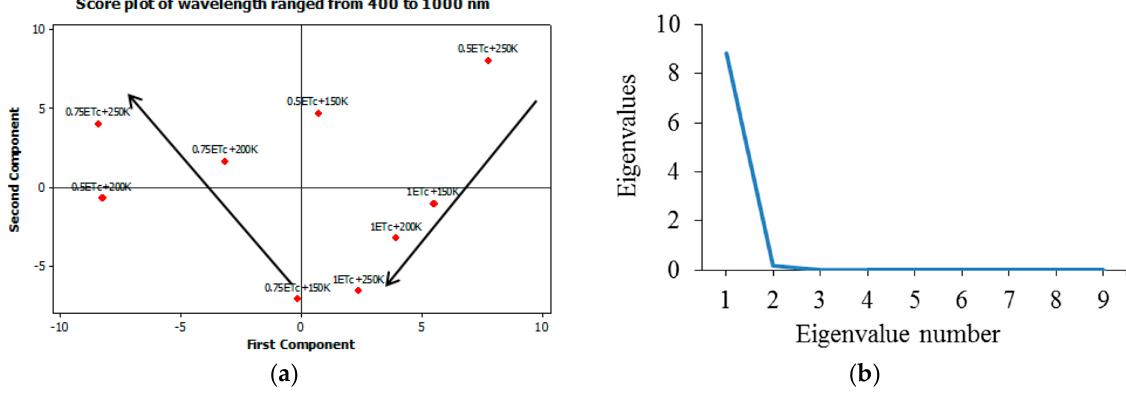
Figure 3. The score plot of ( a ) PCA and ( b ) Eigenvalue number created for the spectral measure- ments acquired from non-stressed and stressed squash plants at the flowering stage in spring season. Treatment labels; 0.50ETc + 150K (50% ETc watering regime and 150 kg K 2 O 5 /ha potassium fertilization rate).